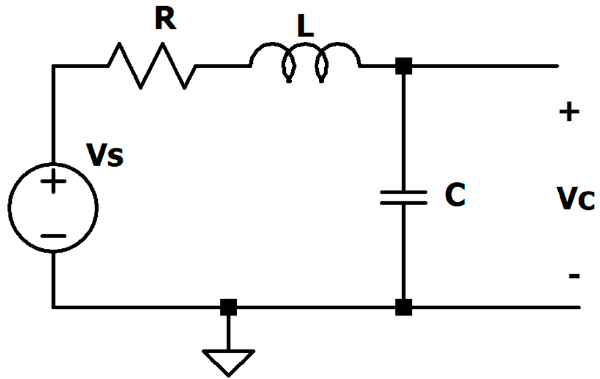
Figure 7. Simple RLC equivalent circuitry to model actuator behavior.